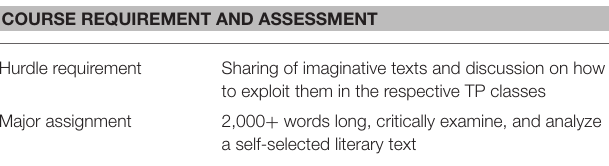
TABLE 7 | Overview of assessment tasks in Jason’s